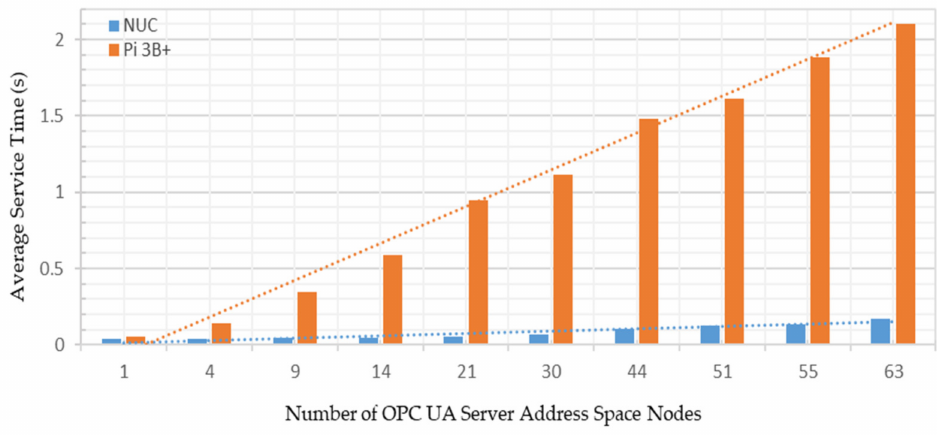
Figure 23. Average service time requirement with varying the server address space nodes.